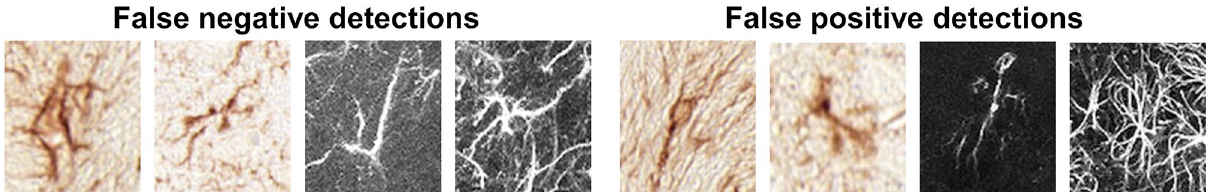
Figure 6. Examples of misclassification. Representative sub-images extracted from the BBBC and Kruyer datasets show examples of astrocytes that where missed (false negative detections, first four columns) or incorrectly identified (false positive detections, last four